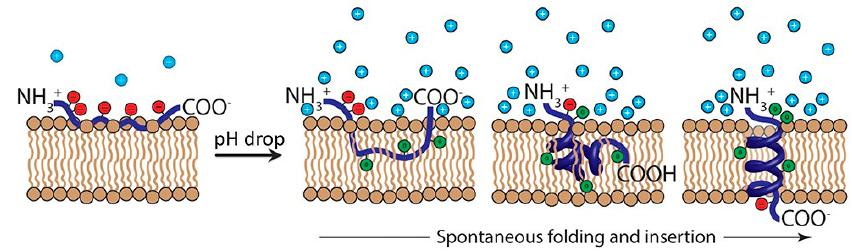
Figure 2. Mechanism of pH (Low) Insertion Peptide (pHLIP) Insertion into the Cellular Membrane. In healthy tissue where the pH is around 7.4, the ionizable residues of the pHLIP (red circles) remain deprotonated and negatively charged, and the peptide resides at or near the hydrophilic surface of the cellular membrane. Upon exposure to acidic tumor microenvironment, the ionizable residues and negatively charged C-terminal carboxyl group of the pHLIP become neutrally charged (green circles). The protonation results in an increase in the hydrophobicity of the pHLIP, triggering the pHLIP to spontaneously fold into a helix and insert across the hydrophobic lipid bilayer of cell membrane, resulting in the formation of a transmembrane helix. Following internalization and exposure to cytosol with pH above 7, C-terminal ionizable residues are deprotonated again and anchor the pHLIP into the membrane. Reproduced with permission from Linden C. Wyatt, Jason S. Lewis, Oleg A. Andreev,